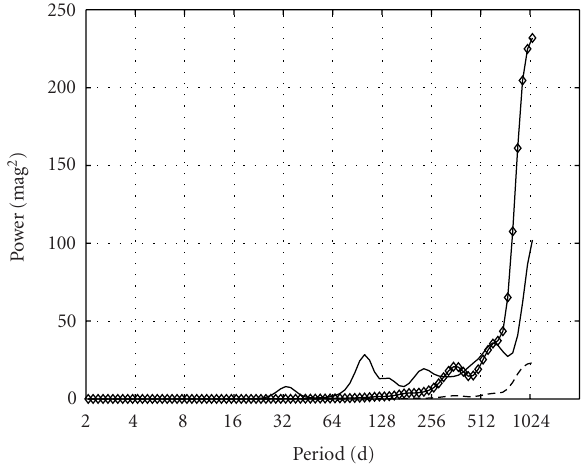
Figure 10: Global wavelet spectrum of the simulated signal made from the RV Tauri sampling (solid line) compared to the GWS from the corresponding sampling signal (dashed line). The solid line with diamonds represents the dashed line multiplied by a factor 10, for clarity.